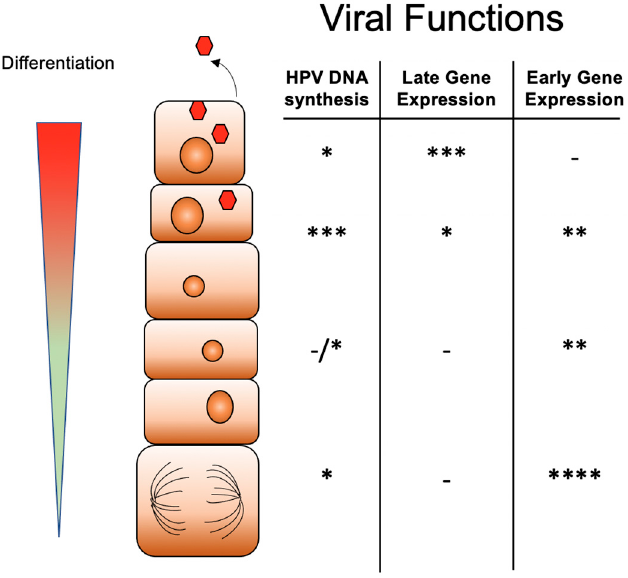
Figure 1. Differentiation-dependent life cycle of high-risk HPVs. Infection by HPV virions occurs into basal cells where genomes are established as multicopy episomes that replicate together with cellular replication. As HPV infected basal cells divide, one daughter cell migrates away from the basal epithelia to begin to differentiate. Upon differentiation late gene expression is activated while early transcription is reduced. The amplification of HPV genomes, virion assembly and release occur in suprabasal cells. The number of * indicates the level of activity with * indicating low level, ** medium, *** intermediate and **** high